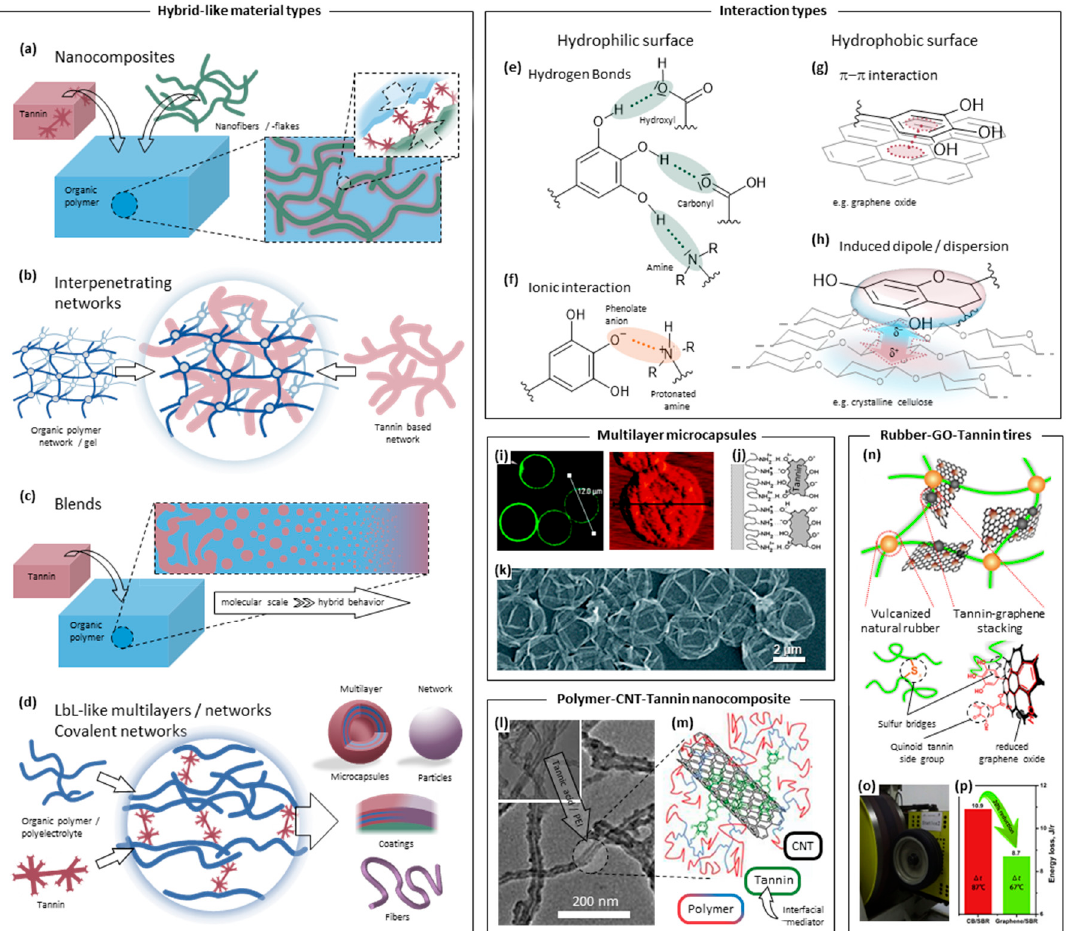
Figure 4. ( a – d ) Schematic representations and structural organization of commonly reported tannin based hybrid-like materials: ( a ) nanocomposites; ( b ) interpenetrating networks; ( c ) blends; and ( d ) physically or covalently crosslinked networks and multilayers (left) and their typical form factors (right). ( e – h ) Types of physical interactions of tannins with different kinds of materials and surfaces. ( i – p ) Examples of various types of hybrid-like materials: ( i – k ) Multilayer microcapsules prepared and stabilized with polyelectrolyte-LbL-like chemistry. ( i – j ) Adapted with permission from [96]. Copyright 2005 American Chemical Society. ( k ) Adapted with permission from [97]. Copyright 2010 Royal Society of Chemistry. ( l , m ) Nanocomposites based on the functionalization of pristine carbon nanotubes (inset) with tannin and polyethylenimine ( l ) and the proposed structural organization of resulting epoxy composites ( m ). Adapted with permission from [98]. Copyright 2018 Elsevier Inc. ( n – p ) Hybrid rubber–graphene oxide–tannin elastomer with suggested molecular organization ( n ) and its utilization to prepare and test car tires ( o ) with low energy loss ( p ). Adapted with permission from [99]. Copyright 2016 Elsevier